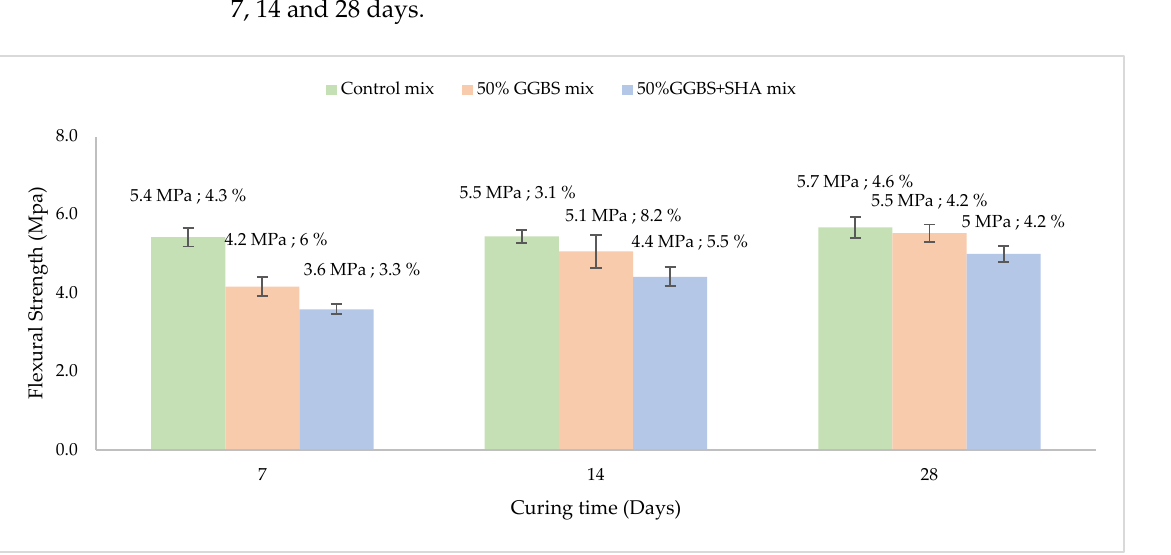
Figure 9. Mix comparison (Dynamic modulus of Elasticity; Coefficient of variation). From the control mix in the figure above, the evolution of the dynamic modulus of elasticity for the control mix is observed throughout the 28 days of curing, with an increase of 5% from the seventh to the 28th day.